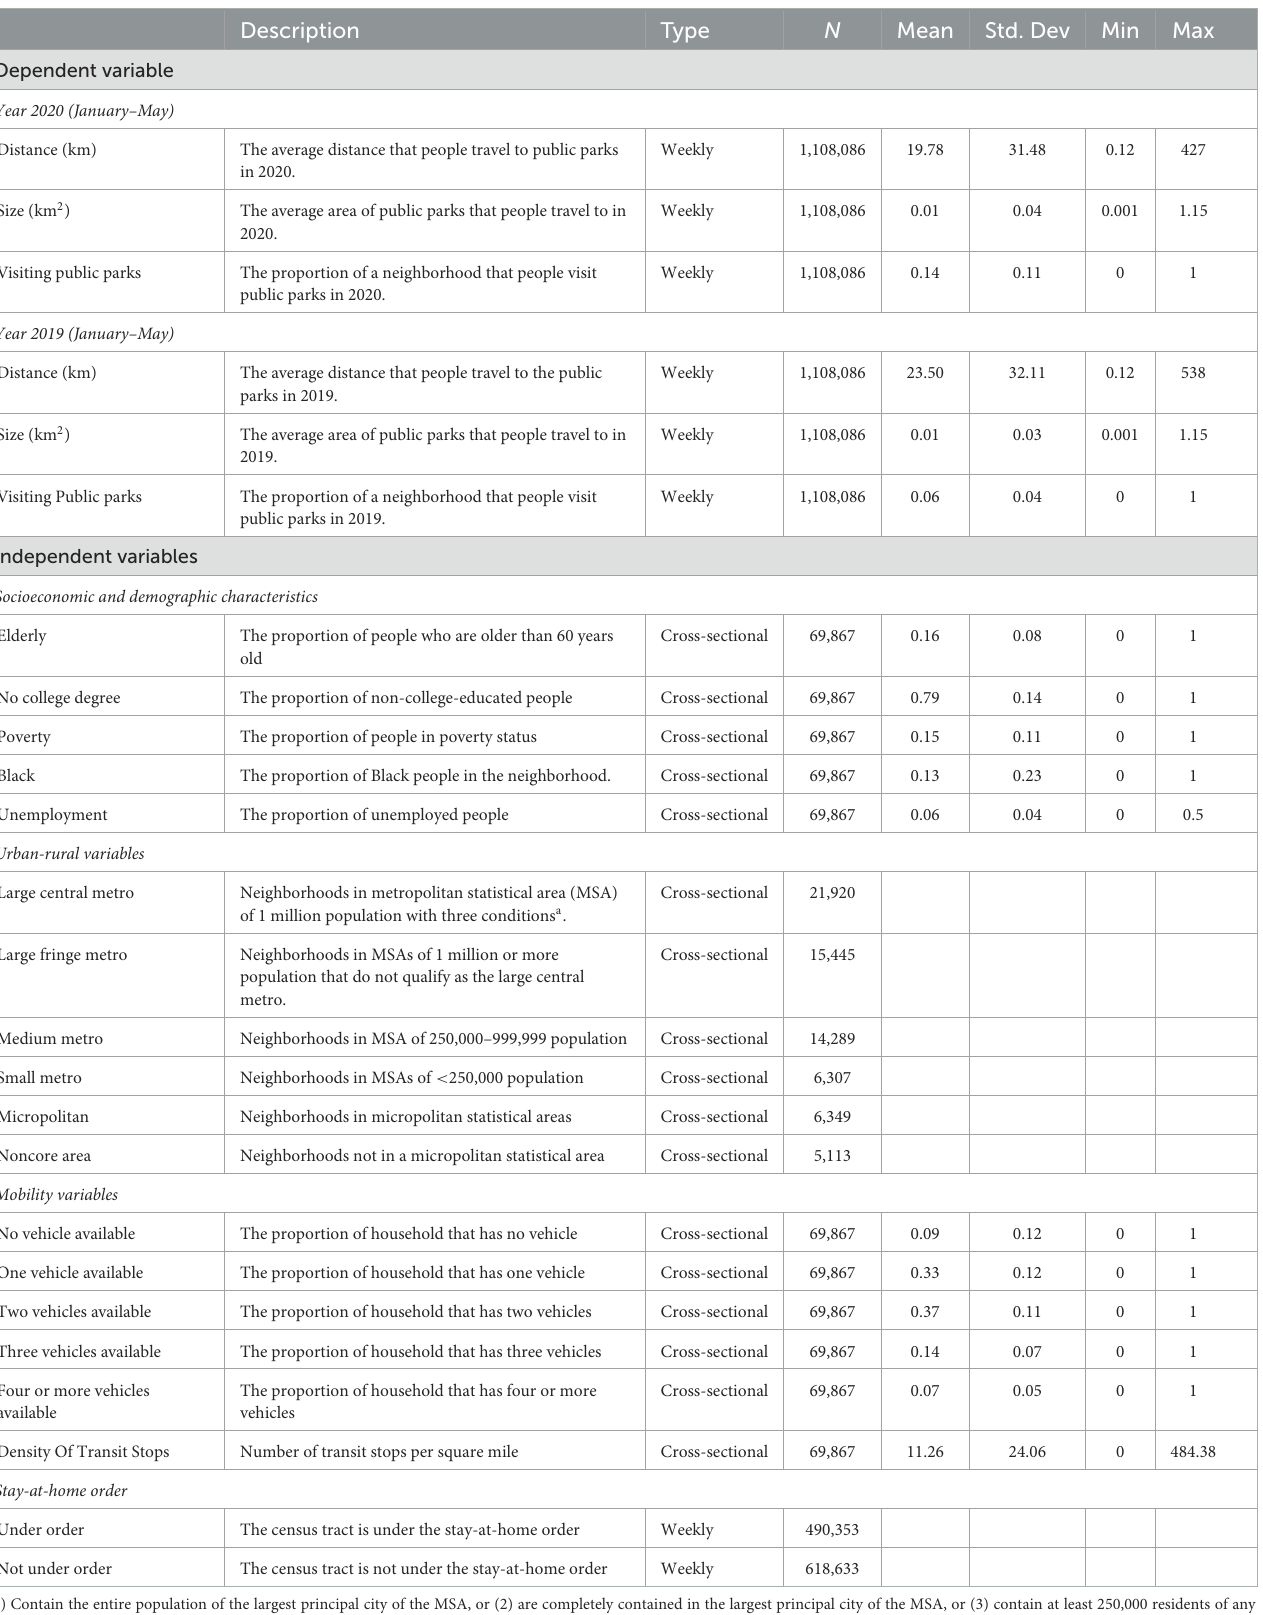
TABLE 1 Descriptive statistics of all variables for all census